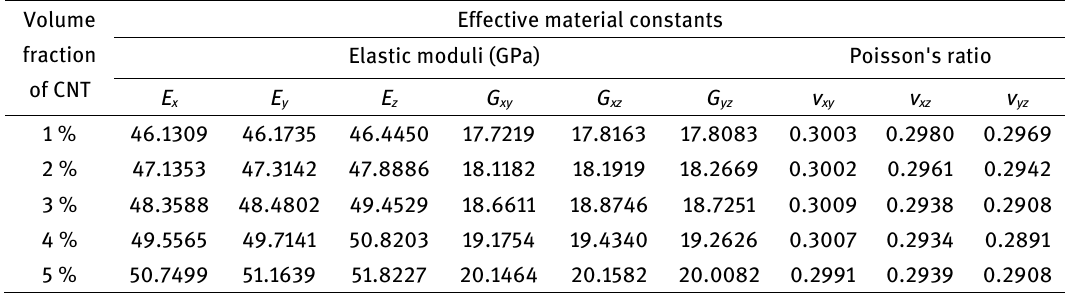
Table 4: Effective material constants of randomly-oriented & -positioned ESF-reinforced Mg-nanocomposite.